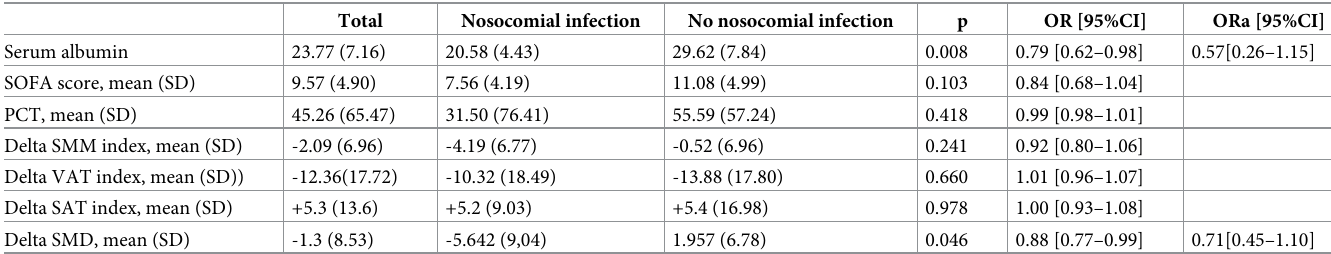
Table 4. Risk factors associated with nosocomial infection.